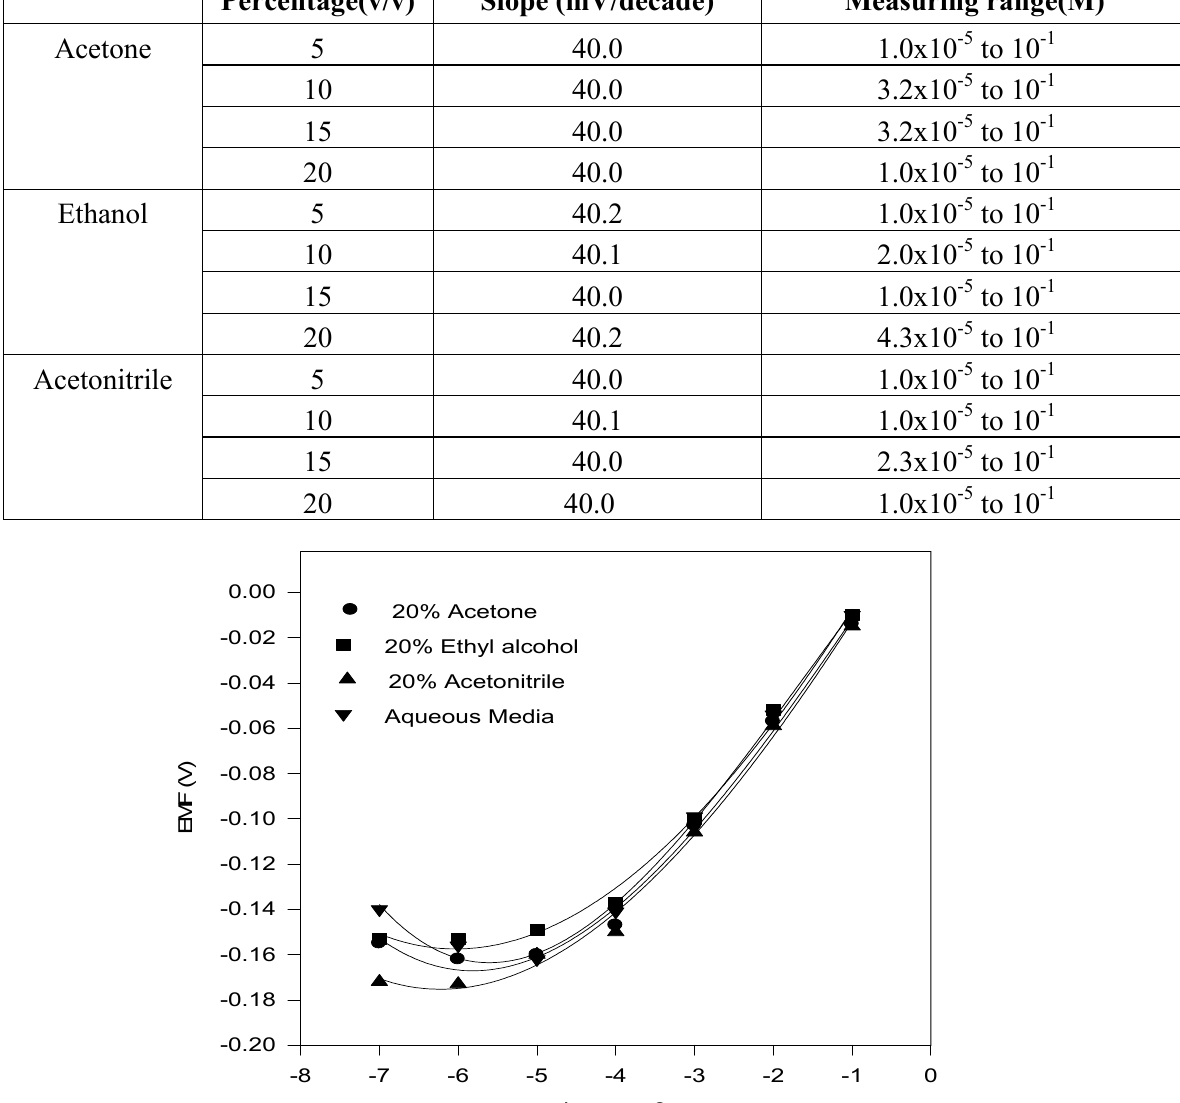
Figure 4. Effect of partially non-aqueous medium on potential response of Sm (III) selective electrode based on